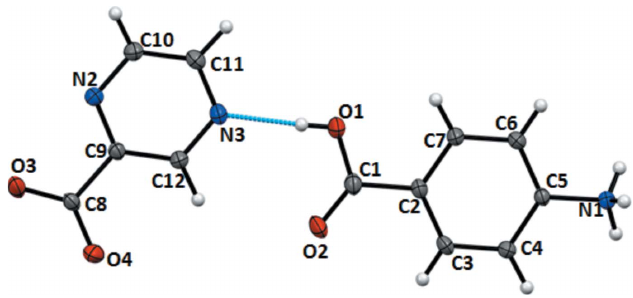
Figure 1 The asymmetric unit of the title compound at 150 K, with displacement ellipsoids drawn at the 50% probability level for non-H atoms. H atoms are shown as spheres of arbitrary radii.